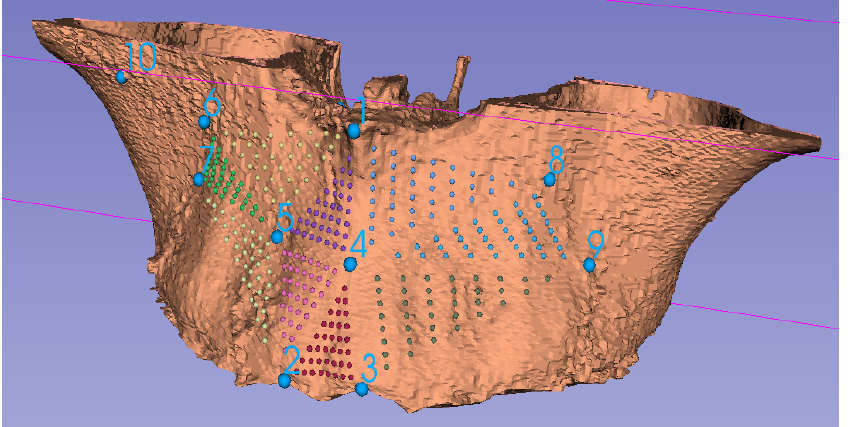
Figure 8. Using CBCT data, the maxillary complex has been rendered in 3D and the semi-landmarks (colored points) have been computed using the ten homologous landmarks (1–10).